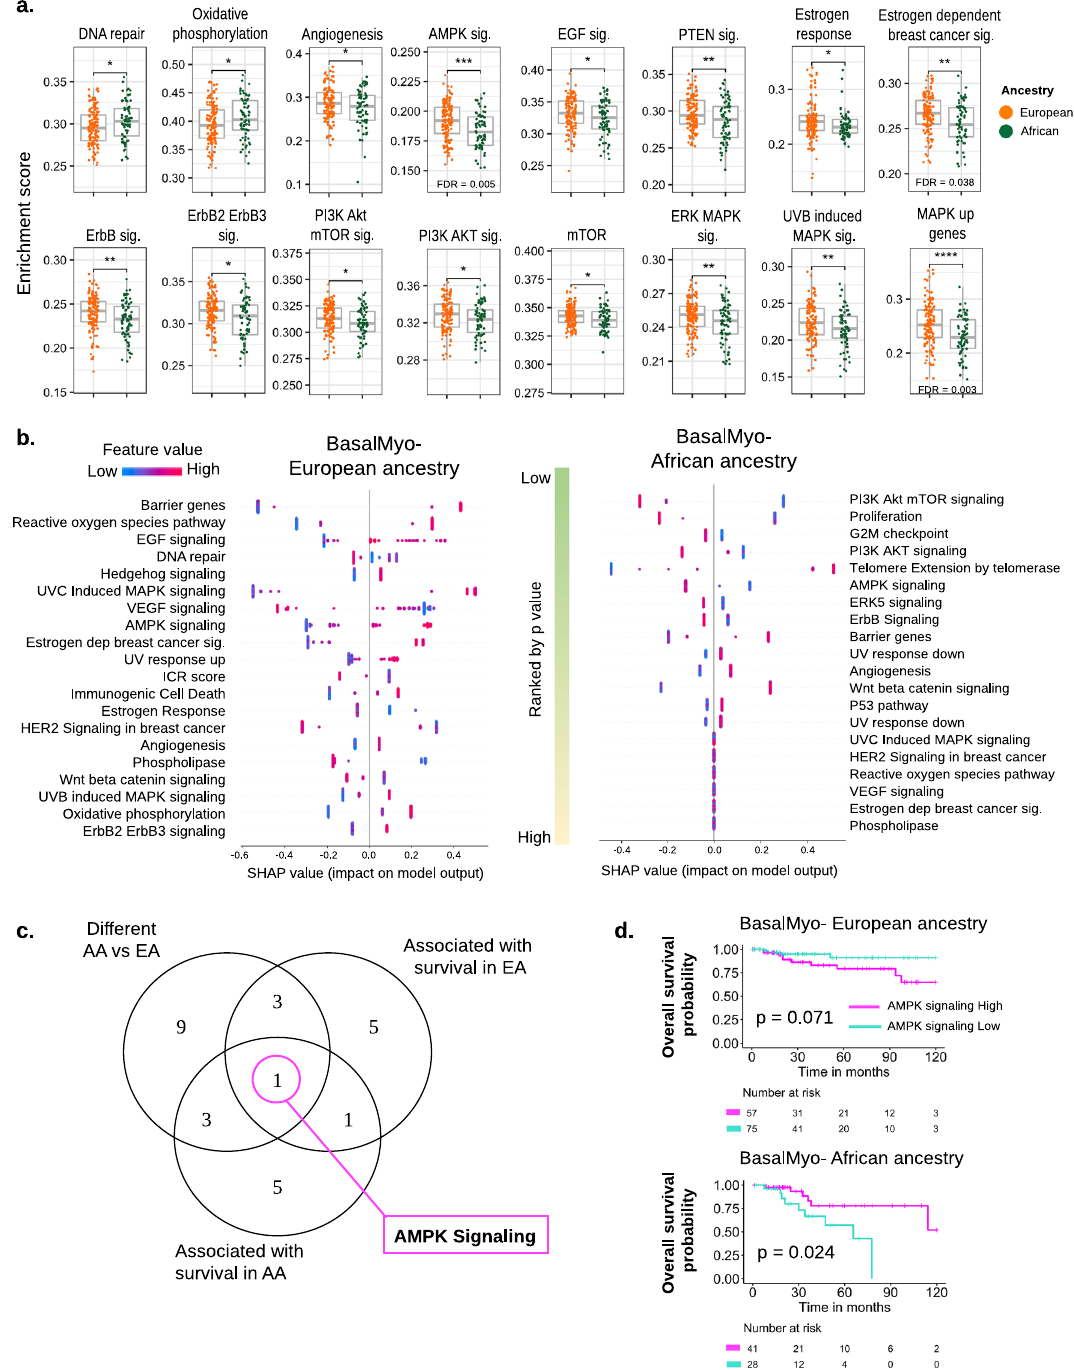
Fig. 4 Differentially enriched oncogenic pathways with prognostic connotation in EA and AA patients with BasalMyo breast tumors. a Enrichment scores of signatures of tumor-associated pathways that are differentially regulated between EA and AA patients with BasalMyo tumors. Box plots indicate medians and interquartile range, and whiskers represent 10th and 90th percentile. All data points are plotted individually. T test (two-sided): * p < 0.05, ** p < 0.01, *** p < 0.001, and **** p < 0.0001. Adjusted p value (FDR) by Benjamini and Hochberg method. b SHAP plots of tumor-associated pathways that are associated with overall survival in EA (left) and AA (right) patients with BasalMyo breast tumors. Pathways are ranked by p value to re fl ect the importance of each feature in the survival model. Each dot represents a single sample and is colored by relative enrichment score. Corresponding impact on model output (SHAP value) ranges from − 1 (indicating the absence of an event) to + 1 (indicating the occurrence of an event, in this case, death). c Intersection of differentially enriched tumor- associated pathways with ten most important pathways in AA and EA patients with BasalMyo breast tumors. AMPK signaling is differentially regulated in AA vs EA and is of importance in survival models of both AA and EA patients. d Kaplan – Meier curves visualizing the prognostic value of AMPK signaling in EA (upper) and AA (lower) BasalMyo patients. Dichotomization of samples by AMPK signaling is based on optimal enrichment score cutoff as determined by XGBoost model. Censor points are indicated by vertical